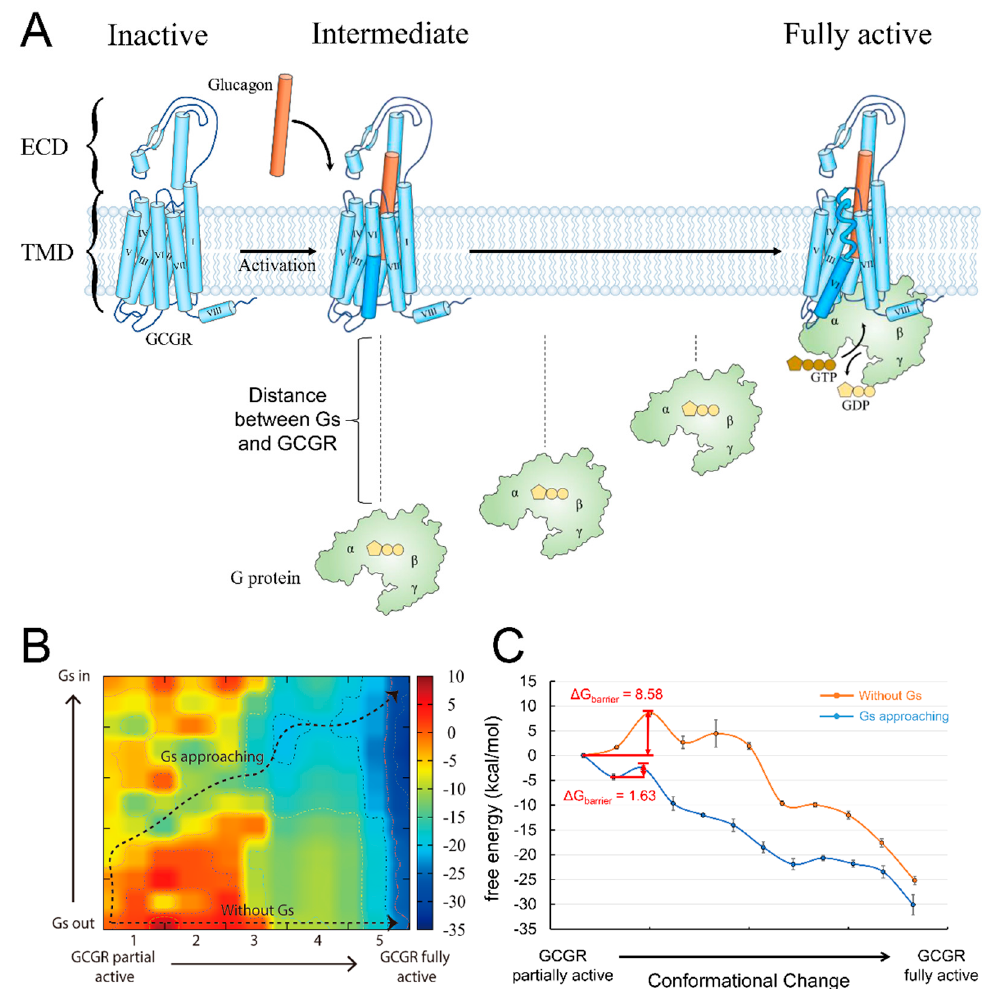
Figure 2. ( A ) Schematic description of GCGR structure and activation pathway. GCGR is shown in light blue, and its TM6 is in dark blue. The glucagon peptide is shown as a cylinder in orange. The G protein is shown in light green. ( B ) The two–dimensional energy map coupling the Gs distance and the conformational change in GCGR from the partially active state to the fully active state. The X axis is the conformational change coordinate, while the Y axis denotes the Gs distance from the receptor. The two black dotted lines with arrows represent the energetic pathways. ( C ) The energy landscape of the corresponding pathway in the two-dimensional energy map.